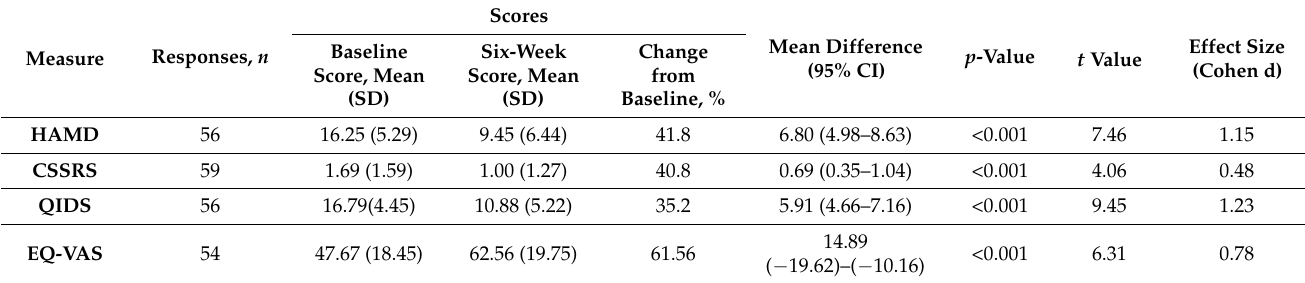
Table 4. Comparison of the baseline and 6-week mean scores on the HAMD-17, CSSRS, QIDS, and EQ-VAS scales for study participants who completed both the baseline and sixth-week scales ( n = 76).